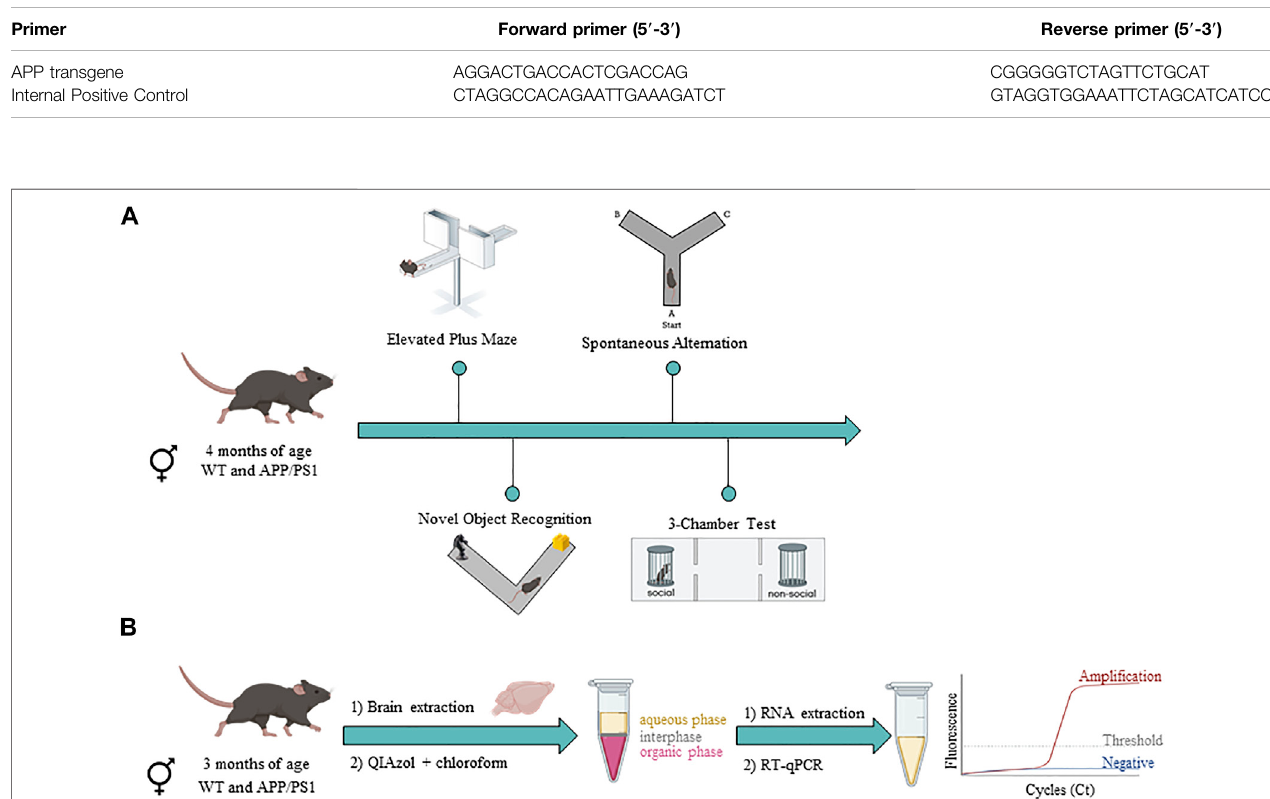
FIGURE1| TimelineofexperimentalproceduresinmaleandfemaleWTandAPP/PS1mouseline. (A) BehavioralassessmentinWT(male n =9;female n =12)and APP/PS1(male n =13;female n =11)miceat4monthsofage. (B) GeneexpressionanalysisinWT(male n =9 – 10;female n =9 – 10)andAPP/PS1(male n =9 – 10;female n = 9 – 10) mice at 3 months of age. Figure created with